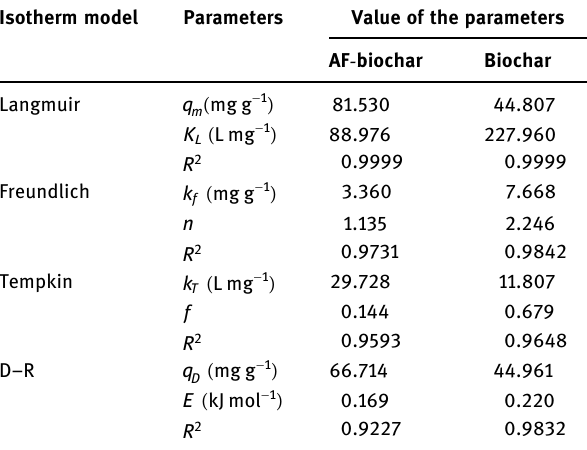
Table 2: Parameters of pseudo - fi rst - order, pseudo - second - order, and intraparticle di ff usion kinetic models for adsorbing DAP on AF - biochar and Biochar ( conditions: T = 25°C, pH 4.6, and initial con - centration of 25 mg L − 1 )